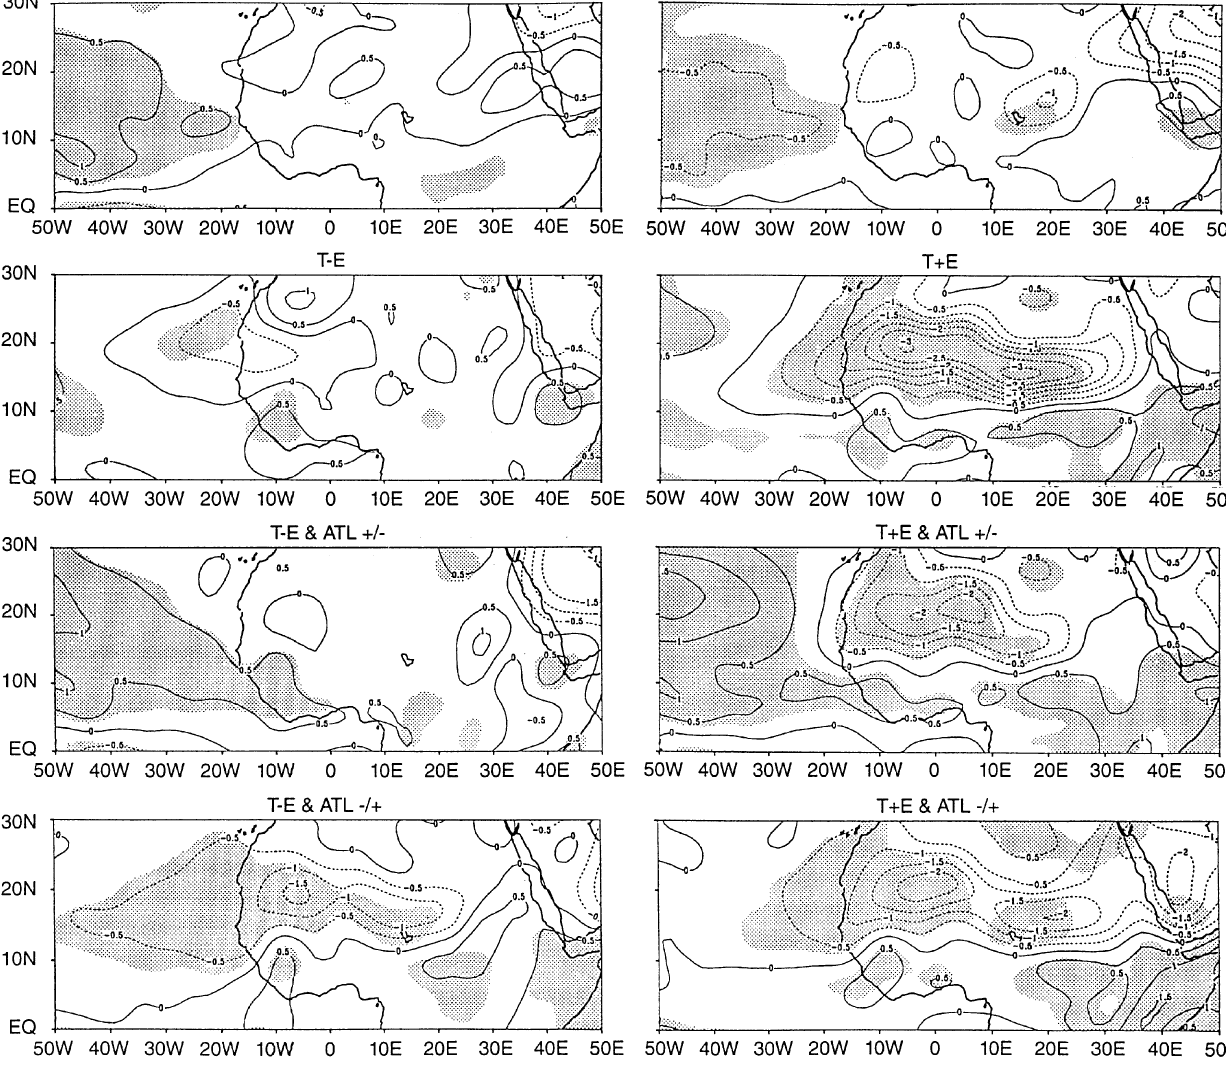
Fig. 9. Specific humidity anomalies at 850 hPa. Positive (negative) anomalies in solid ( dashed ) line every 0.5 g/kg. Areas significant at the 5% level are